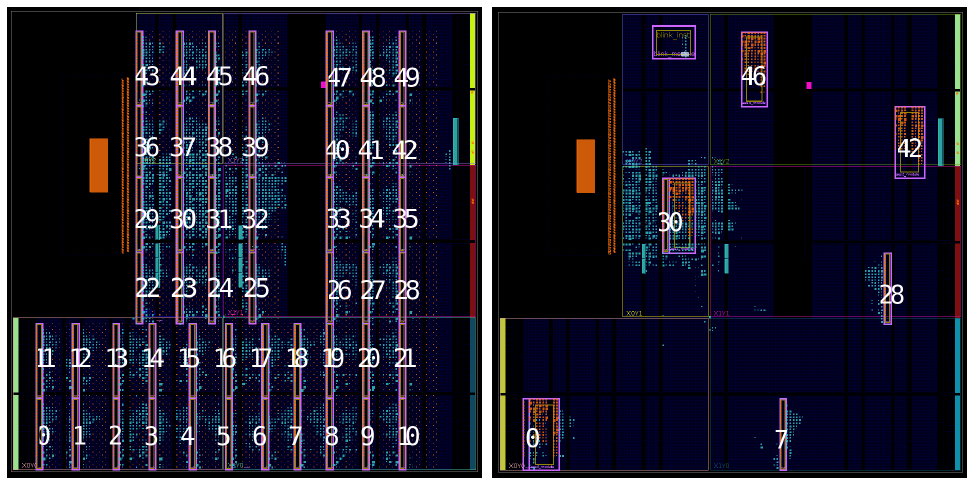
Figure 7: Floorplans of our evaluation designs as seen in the Xilinx Vivado Design software for analyzing the impact of global placement on the entire FPGA and assessing the attack success on four by four different